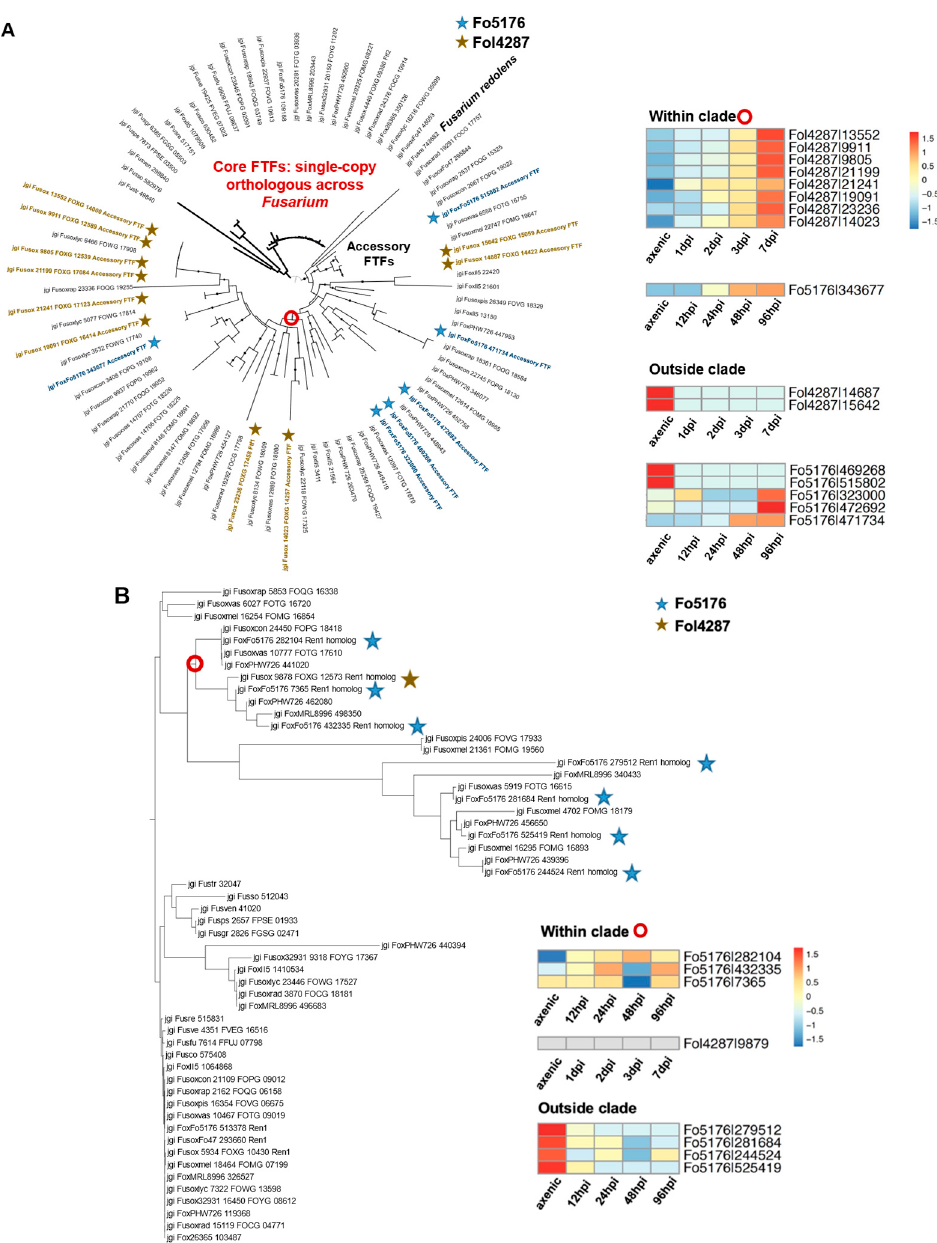
Figure 4. Unique expansion of some TFs, driven by ACs, may provide clues to host-specific adapta- tion. RNA-Seq data were previously described [24,25]. ( A ) Ftf1, the TF involved in tomato pathogenic- ity was most significantly expanded (10 copies of accessory FTFs) in the tomato pathogen Fol4287 genome and the expression of eight out of 10 were induced during plant colonization. ( B ) Ren1 was the most significantly expanded (seven copies of accessory RENs) in the Arabidopsis pathogen Fo5176 genome, and two of them were induced during plant colonization.